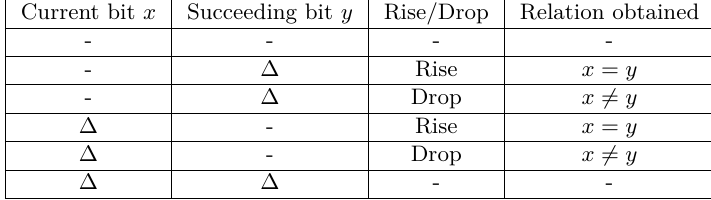
Table 2: Power Consumption Differences and Bit Relations. ‘∆’ indicates there is difference while ‘-’ is no